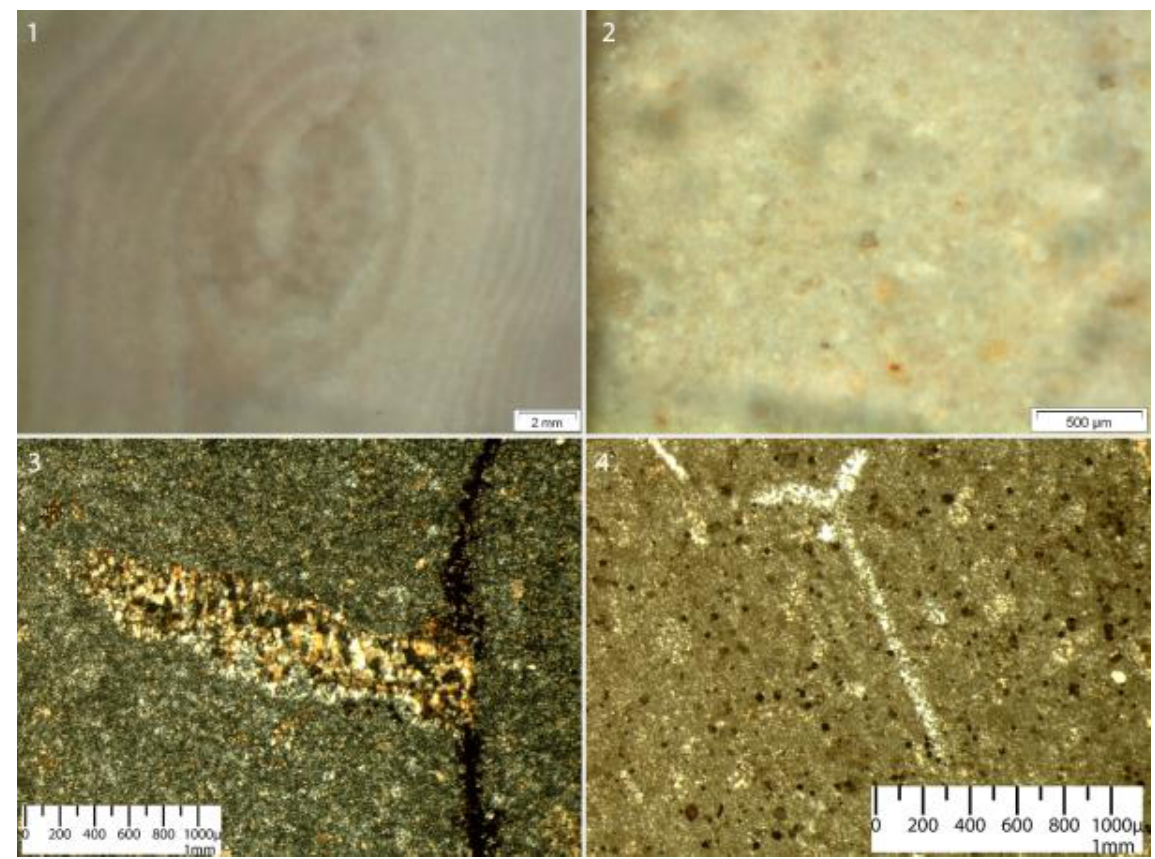
Figure 3. Bajocian flint´s macro and microscopic textures and constituents: 1. Liesegang concentric rings (scale bar = 2 mm); 2. General texture (scale bar = 500 µm); 3. Diaclase cemented by iron oxides and porosity filled by first and second generation micro and macro quartz (scale bar = 1 mm); 4. Triaxonic spicule recrystallized by micro-quartz (scale bar = 1 mm).